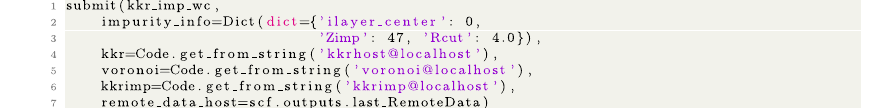
Fig. 4 Submission of the complete impurity embedding work fl ow. The impurity calculation starts from the converged calculation of the Cu bulk system (called scf in Fig. 3). The impurity is speci fi ed via its nuclear charge, the position in the host crystal and the radius of the impurity cluster via the impurity_info input node.